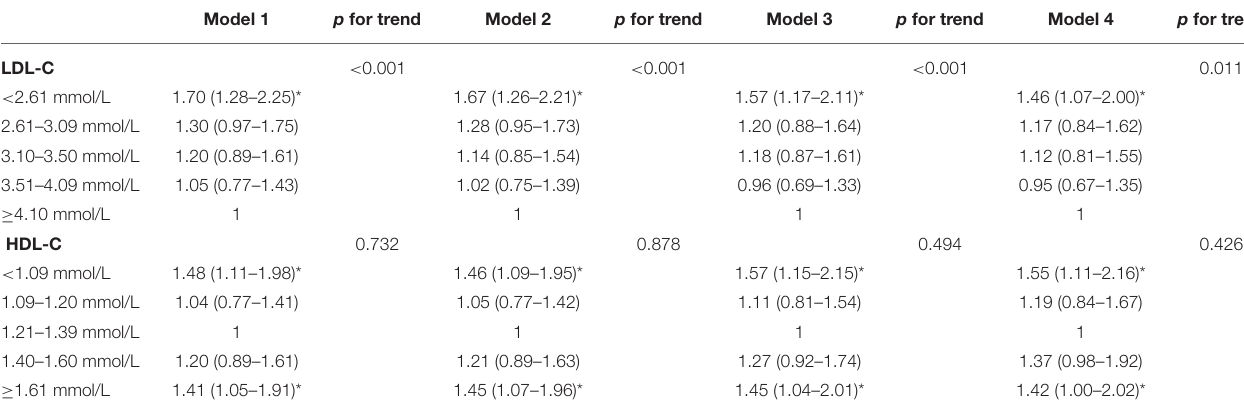
TABLE 2 | Adjusted hazard ratio (95% confidence interval) of all-cause mortality. Model 1 p for trend Model 2 p for trend Model 3 p for trend Model 4 p for trend LDL-C < 0.001 < 0.001 < 0.001 0.011